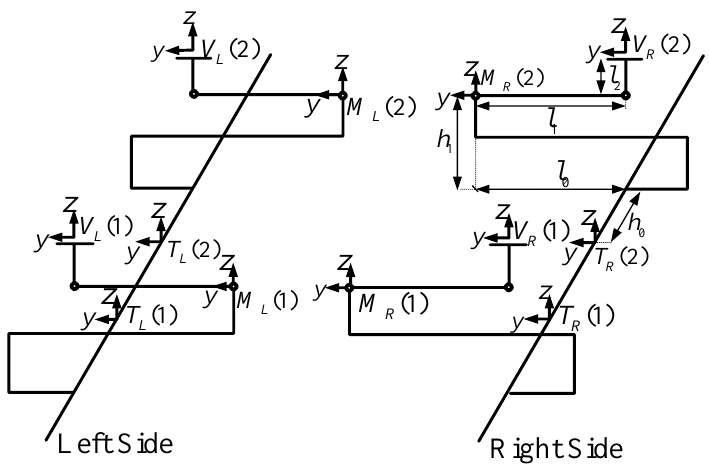
Figure 7. The diagram of secondary system and track